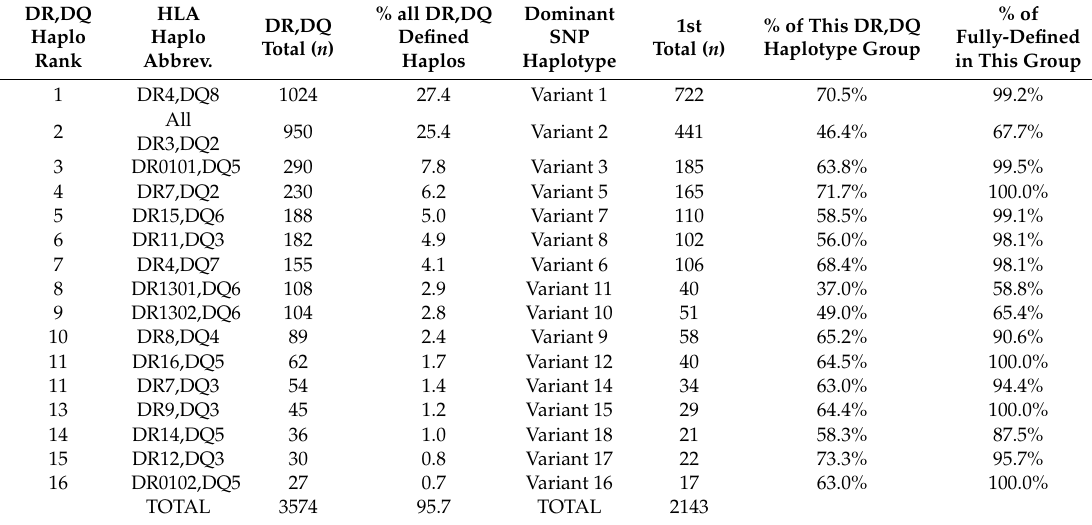
Table 4. Major HLA-DR,DQ haplotypes shared in T1DGC studies: their dominant 27-SNP haplotype and their percentages 1 .